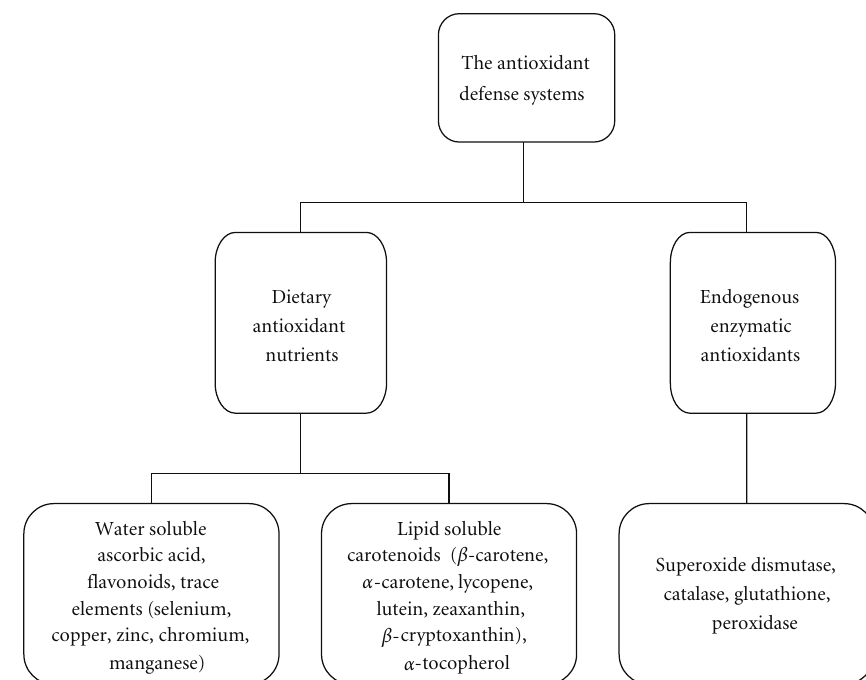
Figure 1: The antioxidant defense system comprise, endogenous enzymatic and exogenous nonenzymatic nutrients. The dietary antioxidant nutrients can either be water soluble or lipid soluble. There are also other dietary constituents that may have either direct antioxidant activity or indirect antioxidant activity such as trace elements that are constituents of antioxidant enzymes.